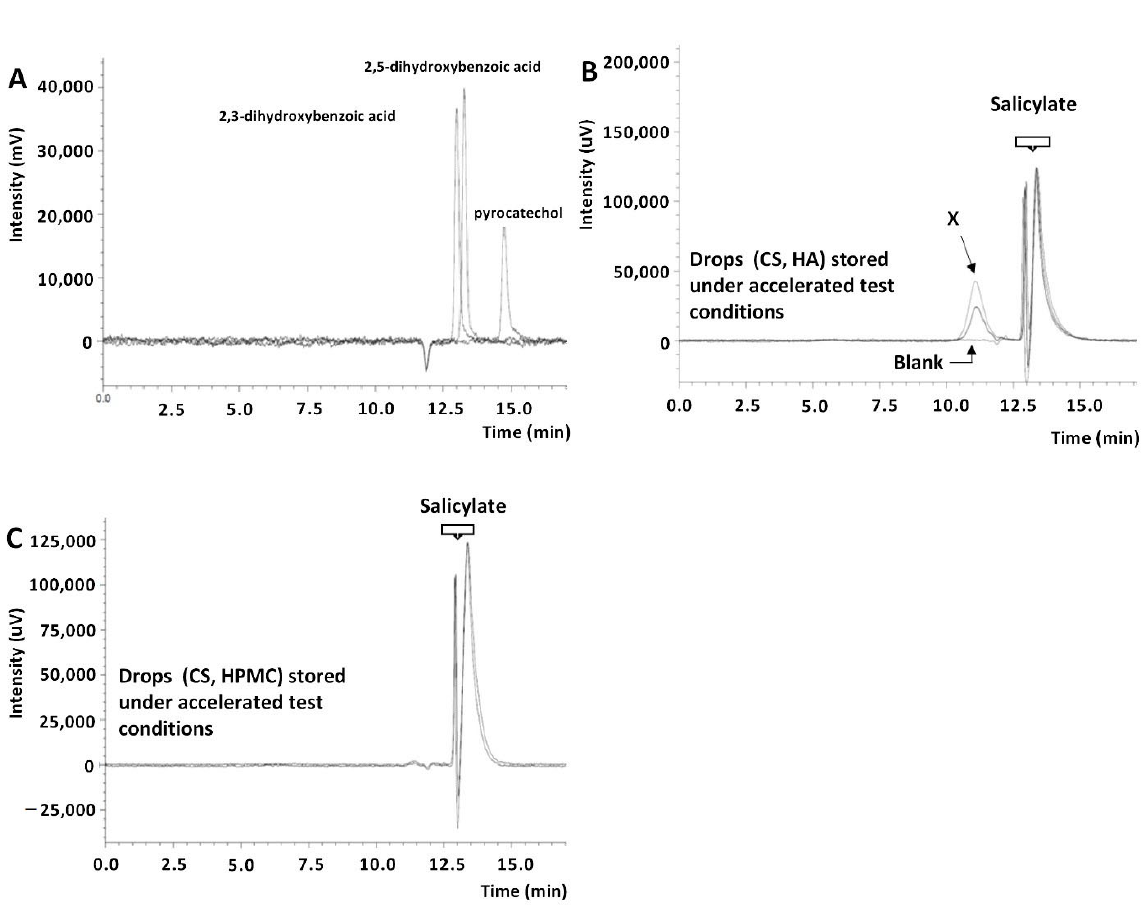
Figure 8. SEC-UV chromatograms: ( A ) standard solutions of CS photodegradation products; ( B ) eye drop solutions with CS (2%) and HA (0.4%) stored under accelerated test conditions (40 ◦ C/75% RH) and a blank test solution; ( C ) eye drop solutions with CS (2%) and HPMC (0.5%) stored under accelerated test conditions (40 ◦ C/75%